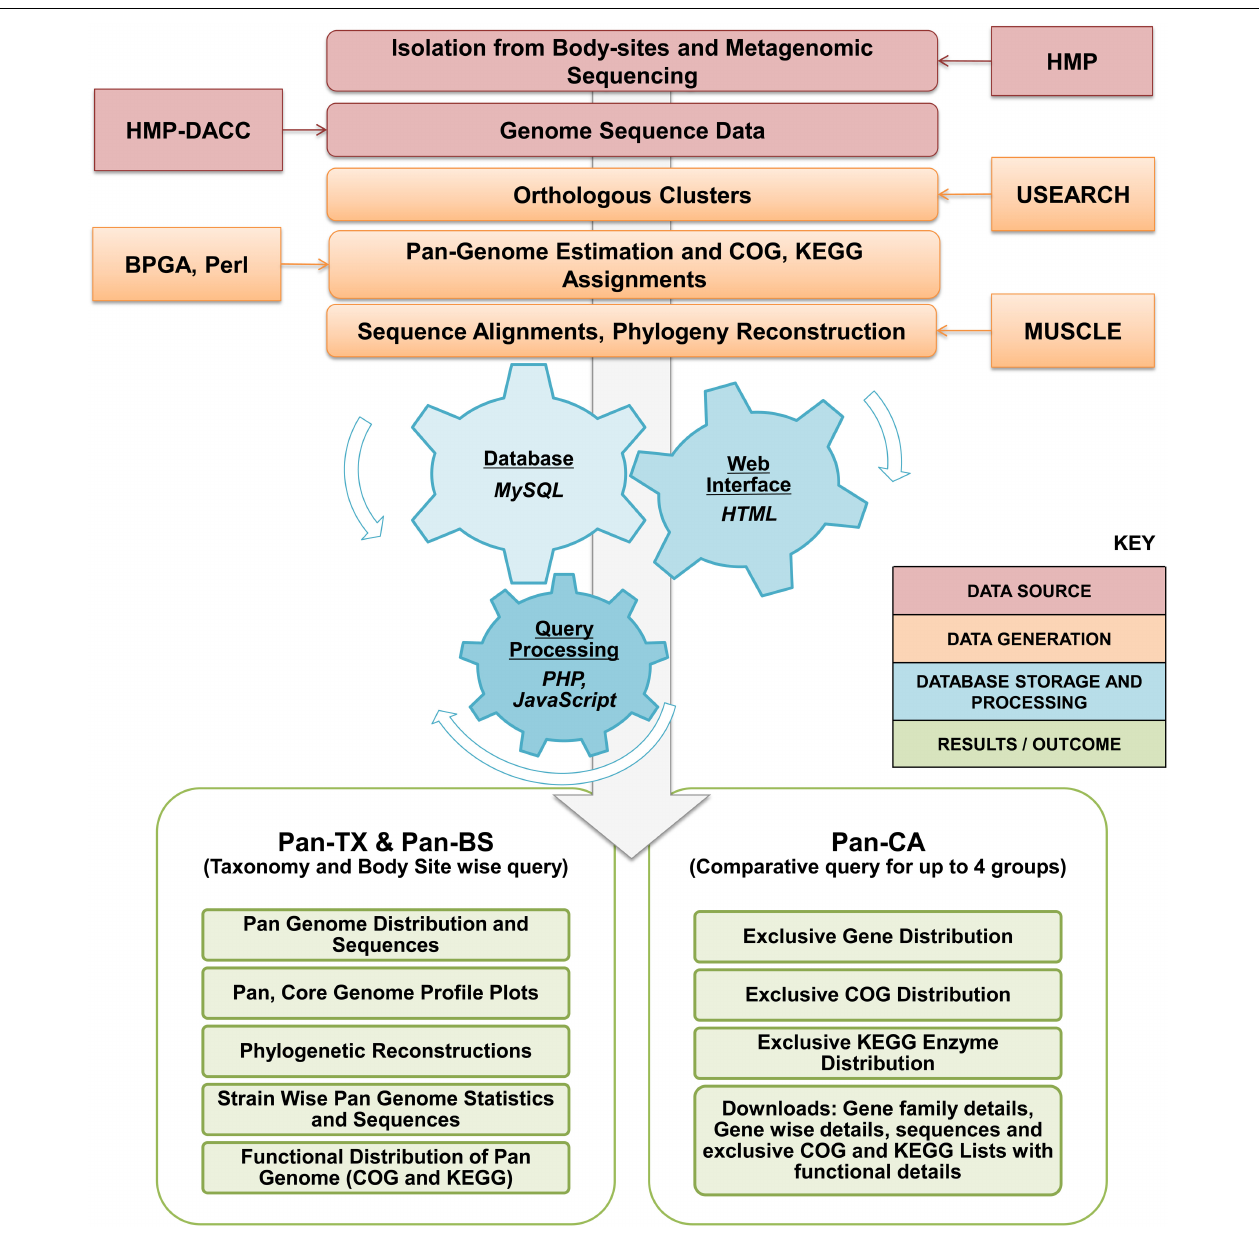
FIGURE 1 | Workflow for PanGFR-HM. The workflow involves preprocessing of the whole genome records from GenBank. The protein sequences from all the available strains are then clustered using USEARCH at various sequence identity cut off levels. The gene presence/absence is determined and stored as a binary matrix using BPGA Pipeline. The tabular data generated after sequence processing and functional assignments are then uploaded into separate MySQL databases for respective sequence identity cut offs. Majority of the backend programs are written in PHP. Finally, various pan genomic and comparative analysis results generated from the set of strains and clustering parameters selected by the users are then provided via the web